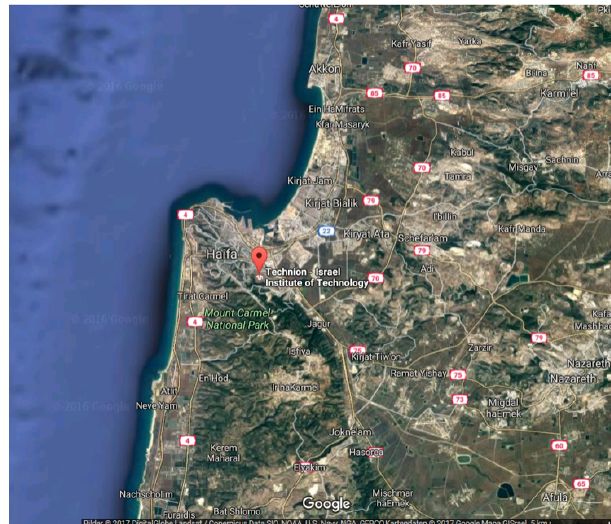
Figure 2. Map of Haifa: the location of the measurement site at the Technion is marked.